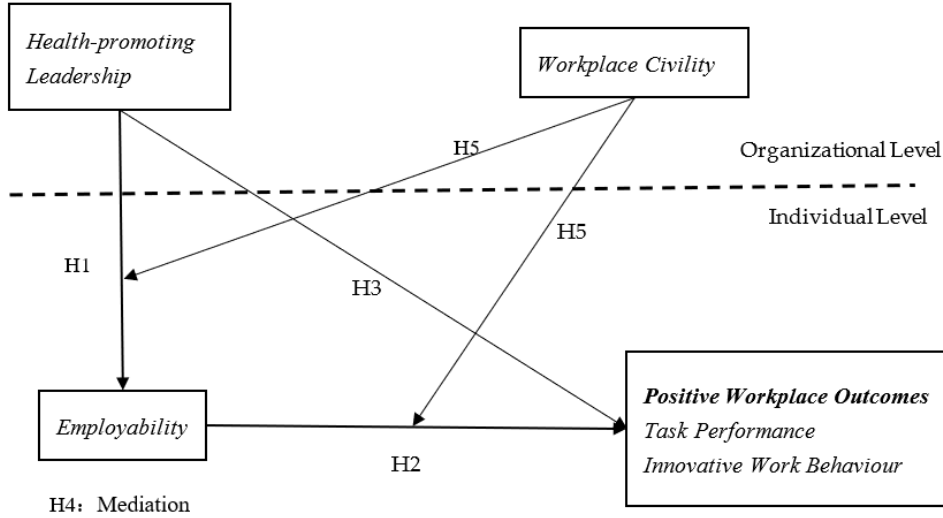
Figure 1. Research Framework.